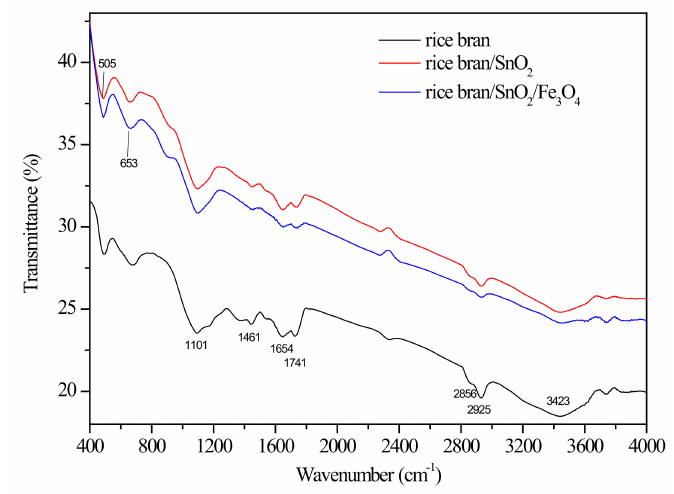
Figure 3. FTIR spectra of the rice bran, rice bran / SnO 2 , and rice bran / SnO 2 / Fe 3 O 4 .